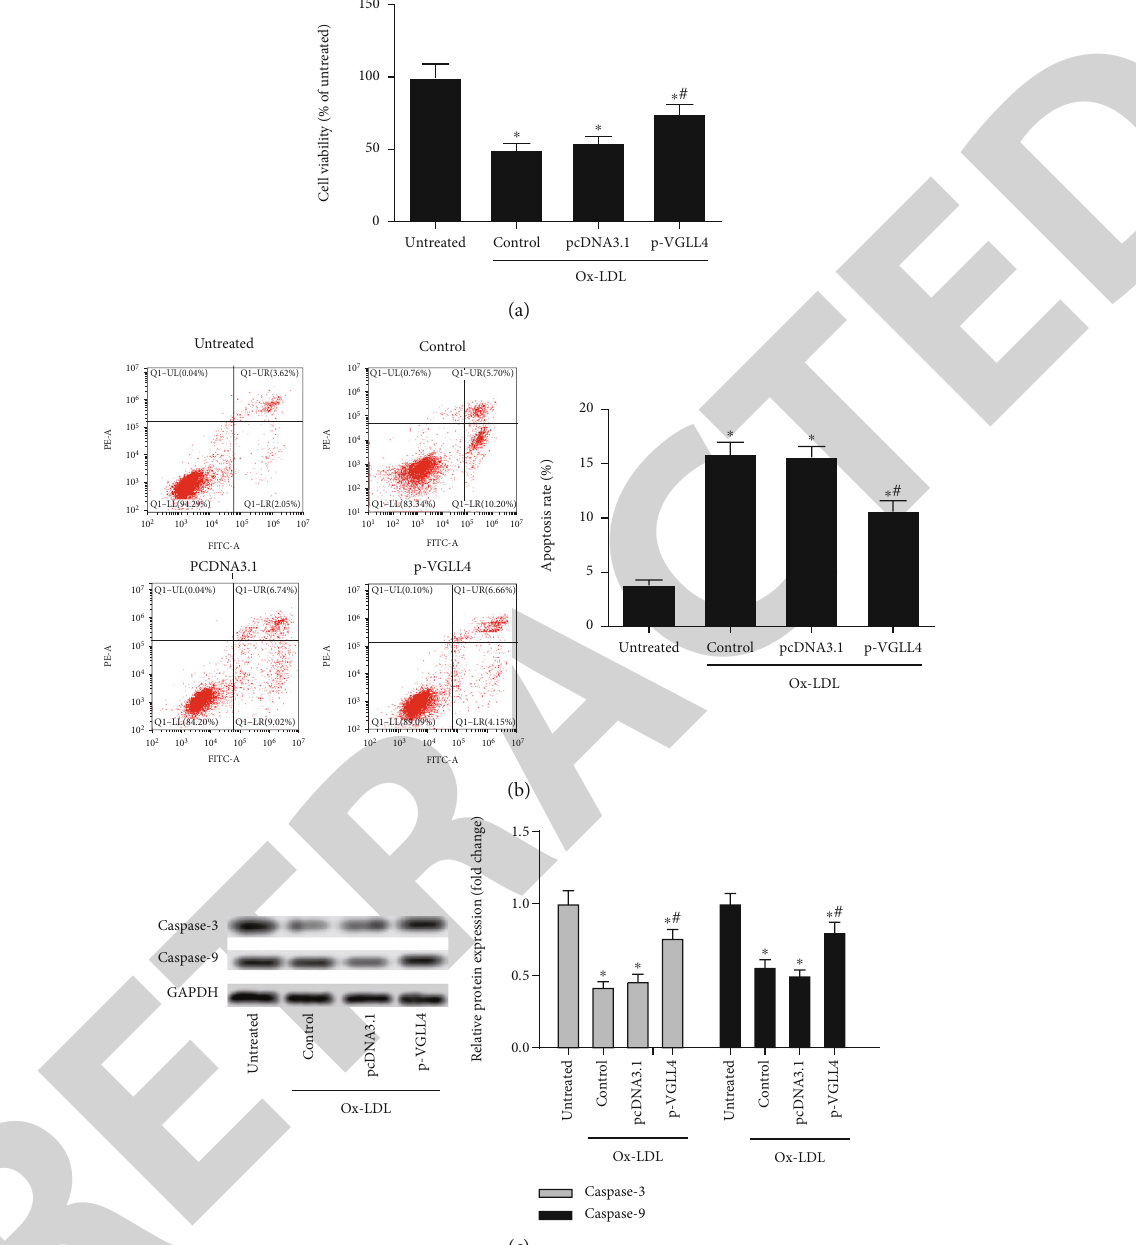
Figure 3: Overexpression of VGLL4 inhibits Ox-LDL-induced apoptosis in HUVECs. The HUVECs were treated with Ox-LDL (100 μ g/mL), and transfected with the control vector (pcDNA3.1 group) or pcDNA3.1-VGLL4 (p-VGLL4 group), respectively. (a) The cell viability in the untreated, control, pcDNA3.1, and p-VGLL4 groups. (b) The apoptosis of HUVECs in the untreated, control, pcDNA3.1, and p-VGLL4 groups. (c) The protein expression of caspase-3 and caspase-9 in the untreated, control, pcDNA3.1, and p-VGLL4 groups. “ ∗ ” means compared with the untreated group at P < 0 : 05 , and “ # ” means compared with the pcDNA3.1 group at P < 0 : 05 . GAPDH was used as an invariant internal control for calculating protein fold